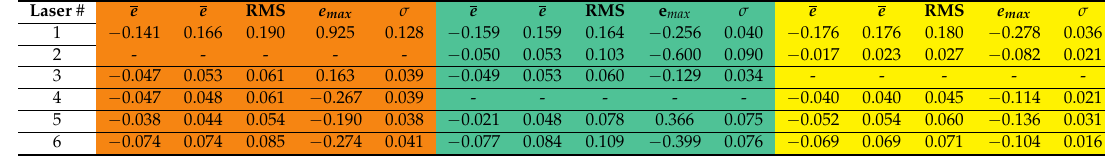
e , root-mean-squared error RMS, maximum error e max and | |